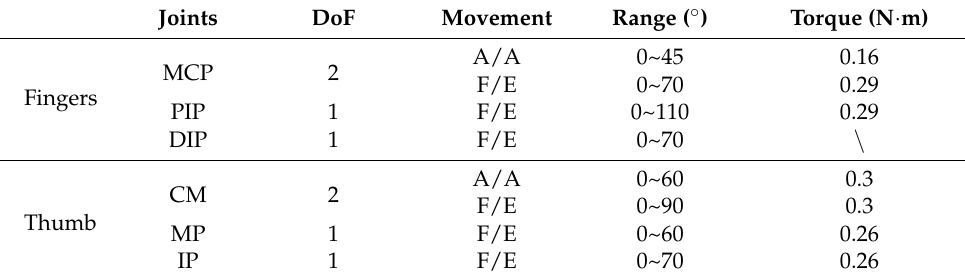
Table 1. Parameters of finger motion